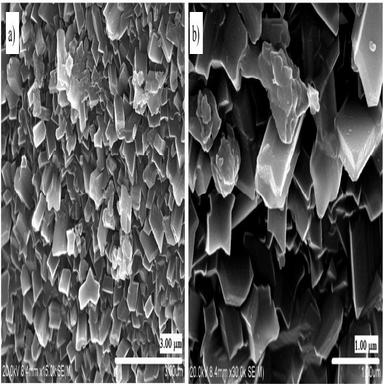
FE-SEM micrographs of B6O sample after calcination at 1500°С at different maginications (a and b).